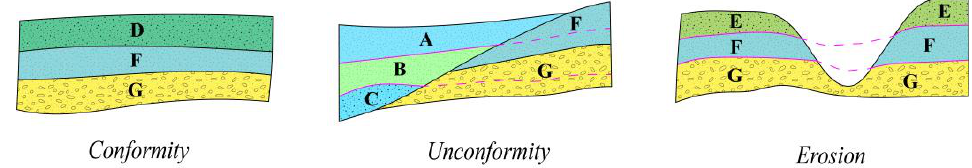
Figure 4. Intersection modes of different contact relationships of Quaternary sedimentary strata.